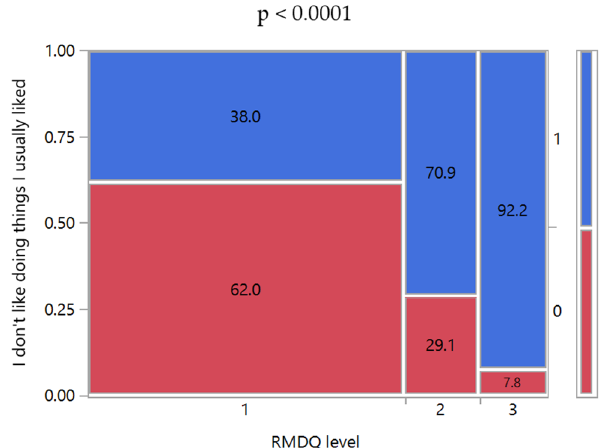
Figure 5. Mosaic plots of SBST Question No. 8 “In general, I don’t like doing things I usually liked” versus RMDQ level. SBST Question No. 8: 0, not agree; 1, agree. RMDQ levels: 1, low; 2, medium; 3, high. The class percentages were reported inside the mosaic plots. Above the graph is the p -value of Pearson’s chi-squared test between the two variables.